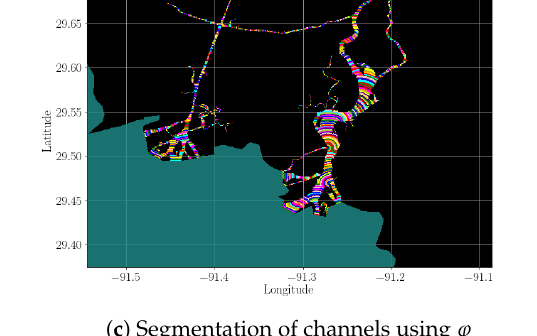
Figure 1. Illustration of our methodology to obtain segments for a channel network using Stamen Terrain-derived water masks over the Wax Lake and Atchaflaya Deltas. The resolution of the water mask is 30 m (zoom level 12). Panel ( a ) shows the initialization of areas including the water mask. Panel ( b ) shows the distance function ϕ . The segments in ( c ) are obtained according to (cid:98) ϕ / D (cid:99) with D = 150 m with each segment randomly colored. We note in panel ( a ) the ocean is a partially transparent yellow, so land areas in the ocean mask appear as